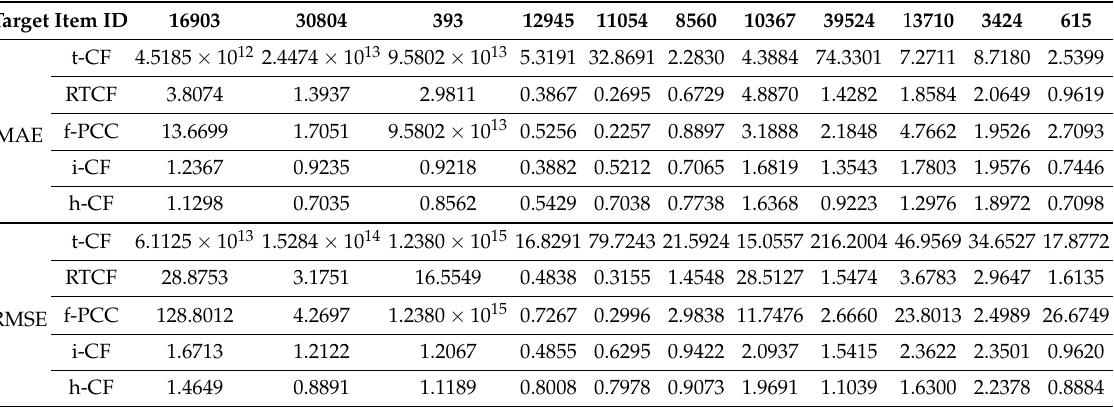
Table 7. Comparison among five methods based on 11